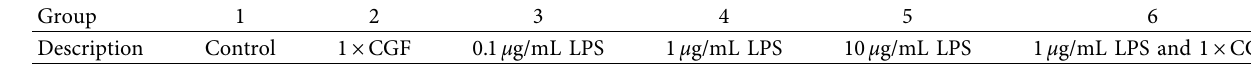
Table 1: Te study groups of the current study.